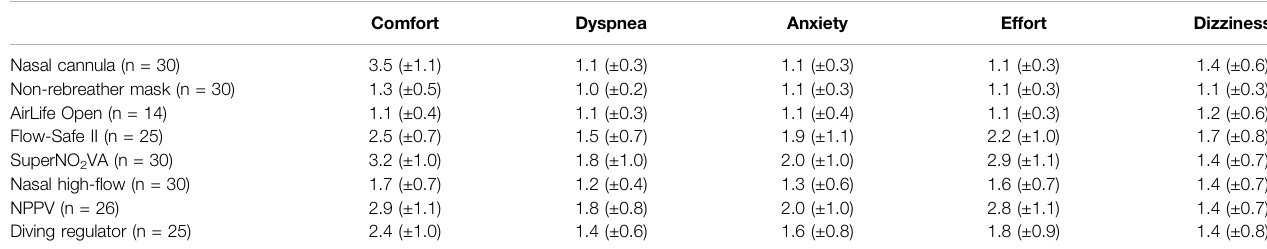
TABLE 4 | Subjective comfort ratings (mean, standard deviation) as reported by the participants. Grading ranged from 1 (excellent) to 5